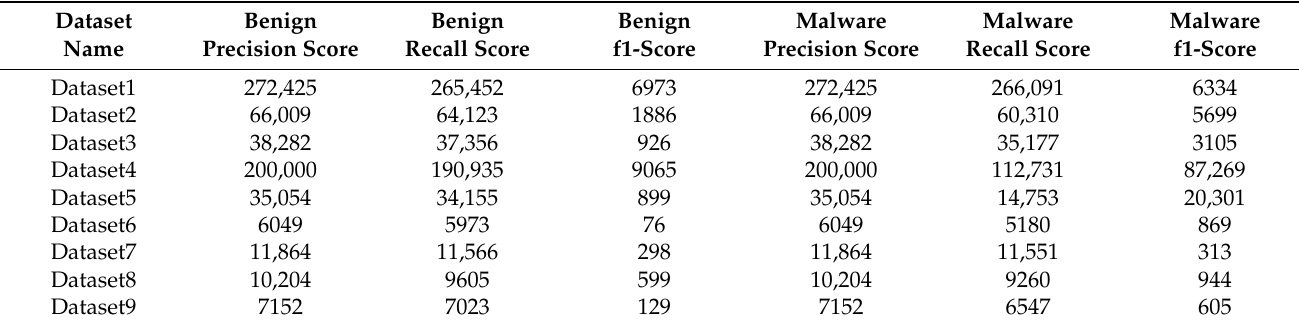
Table 9. Confusion matrix for using the deep learning